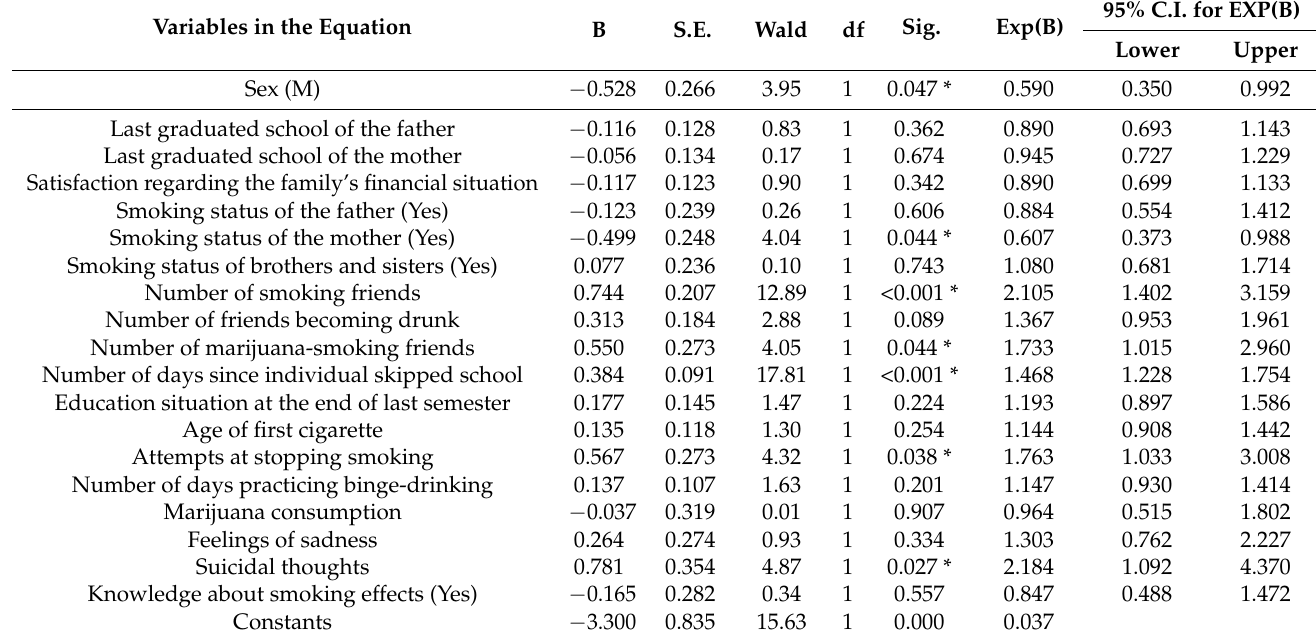
Table 1. Logistic regression to determine the heavy smoker status of college students using smoking as a dependent variable. Variables in the